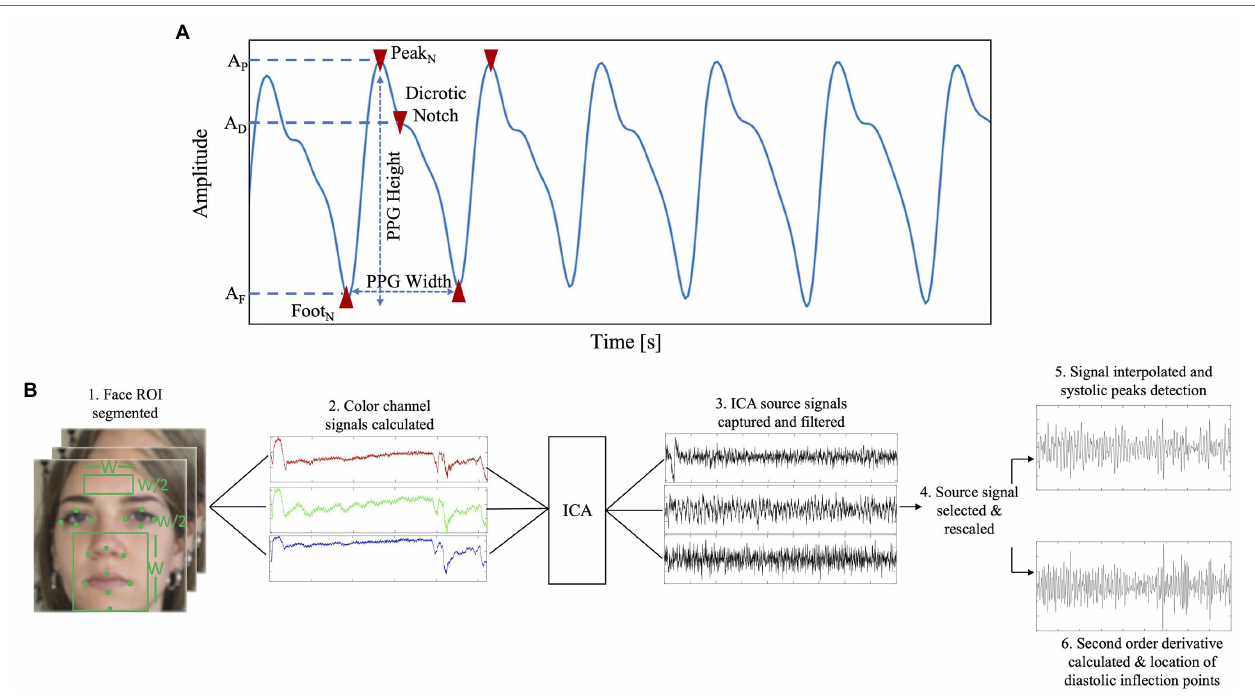
FIGURE 6 | (A) Example of different PPG parameters which can be extracted based on the morphology of the signal (e.g., PPG width, PPG height, dicrotic notch, PPG peak, PPG foot). (B) Flowchart to retrieve SBP and DPB from a rPPG signal (adapted from McDuff et al.,